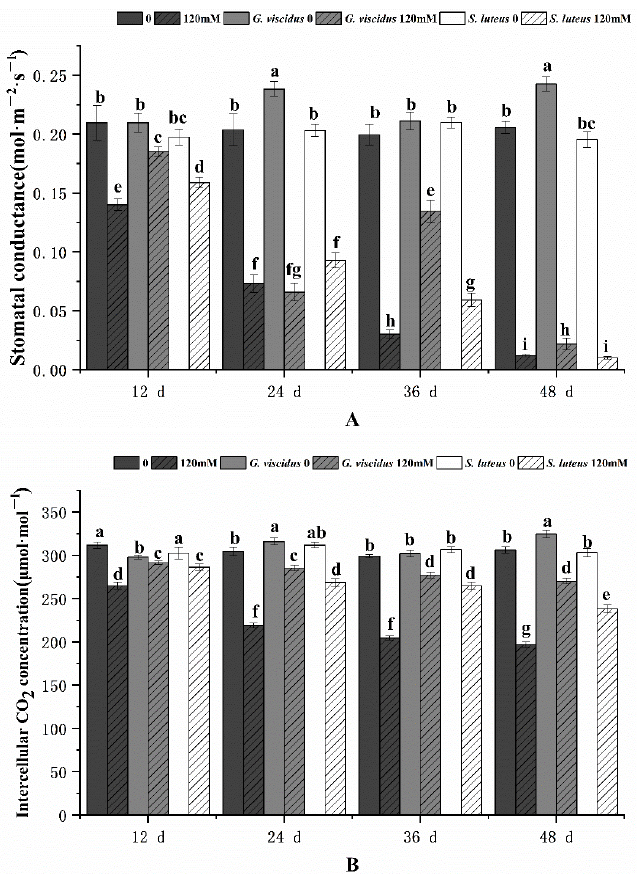
Figure 5. Changes in the stomatal conductance ( A ) and intercellular CO 2 concentration ( B ) in ectomycorrhizal seedlings of Q. mongolica under NaCl stress. Bars represent means of five replicates (±SD). For each parameter, bars with different letters indicate significant differences among treatments, p ≤ 0.05, following one-way ANOVA. Under pre-salt stress, Fv/Fm (Figure 6) showed little change, but at day 36 and 48, Fv/Fm had changed significantly in G. viscidus and S. luteus seedlings compared with con- trol group seedlings. In addition, Fv/Fm was significantly higher in G. viscidus seedlings than in S. luteus seedlings. Fv/Fm on day 48 of 120 mM stress was 1.29 times and 1.09 times higher in G. viscidus and S. luteus seedlings than in control group seedlings, respectively.